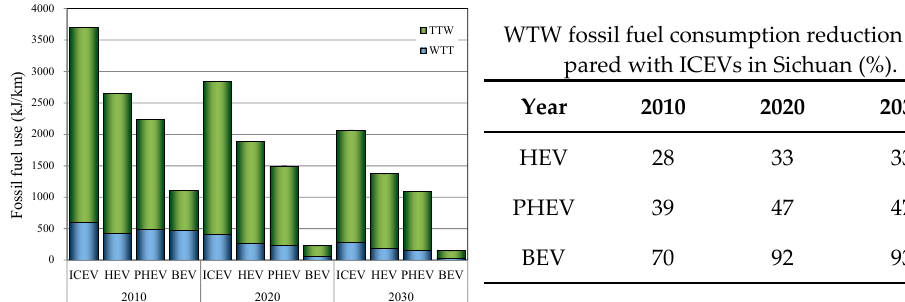
Figure 9. WTW fossil fuel consumption of ICEVs/HEVs/PHEVs/BEVs in Sichuan. HEVs in the two regions show a reduction of 28% on fossil fuel consumption, with both 28% reduction during the WTT and TTW stages, relative to ICEV. With improved generation efficiency, ICEVs and HEVs could decrease fossil fuel consumption by 45– 50% in the two regions from 2010 to 2030.